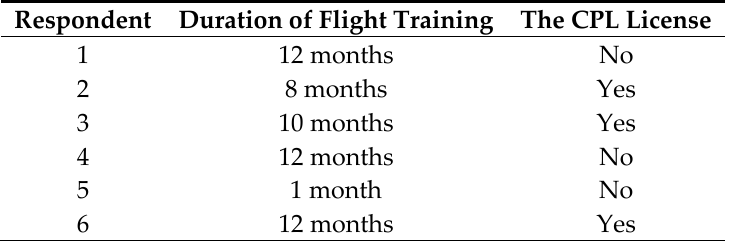
Table 1. The background information of FSP subjects.